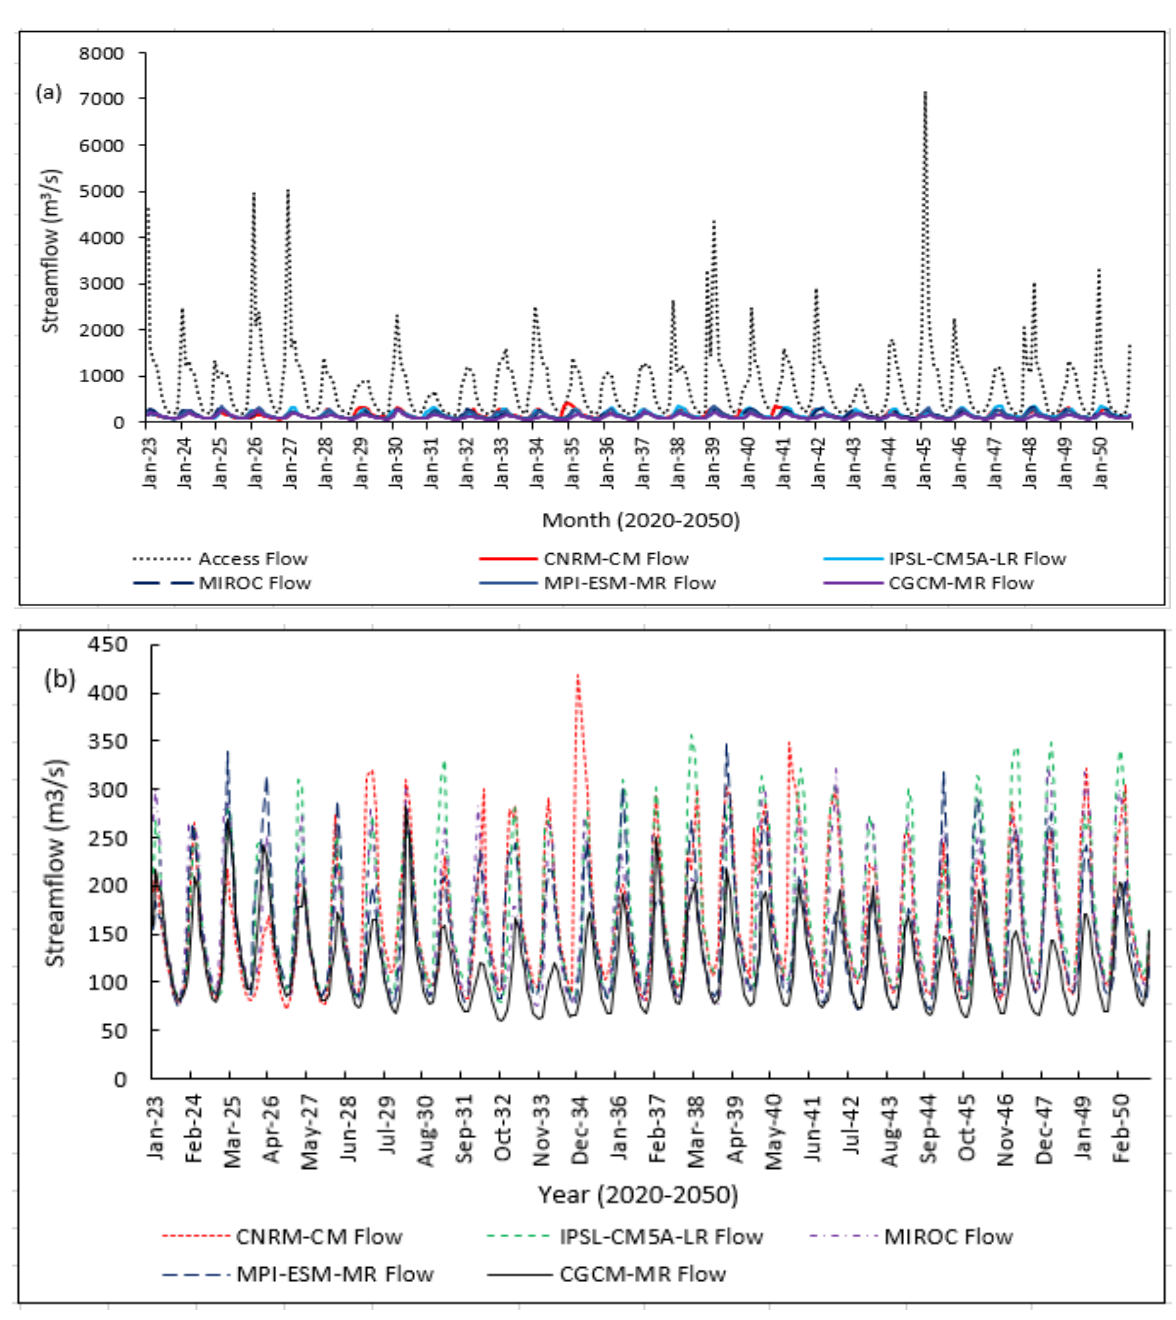
Figure 8. Monthly streamflow for RCP 8.5 for ( a ) high uncertainty; and ( b ) strong consensus.